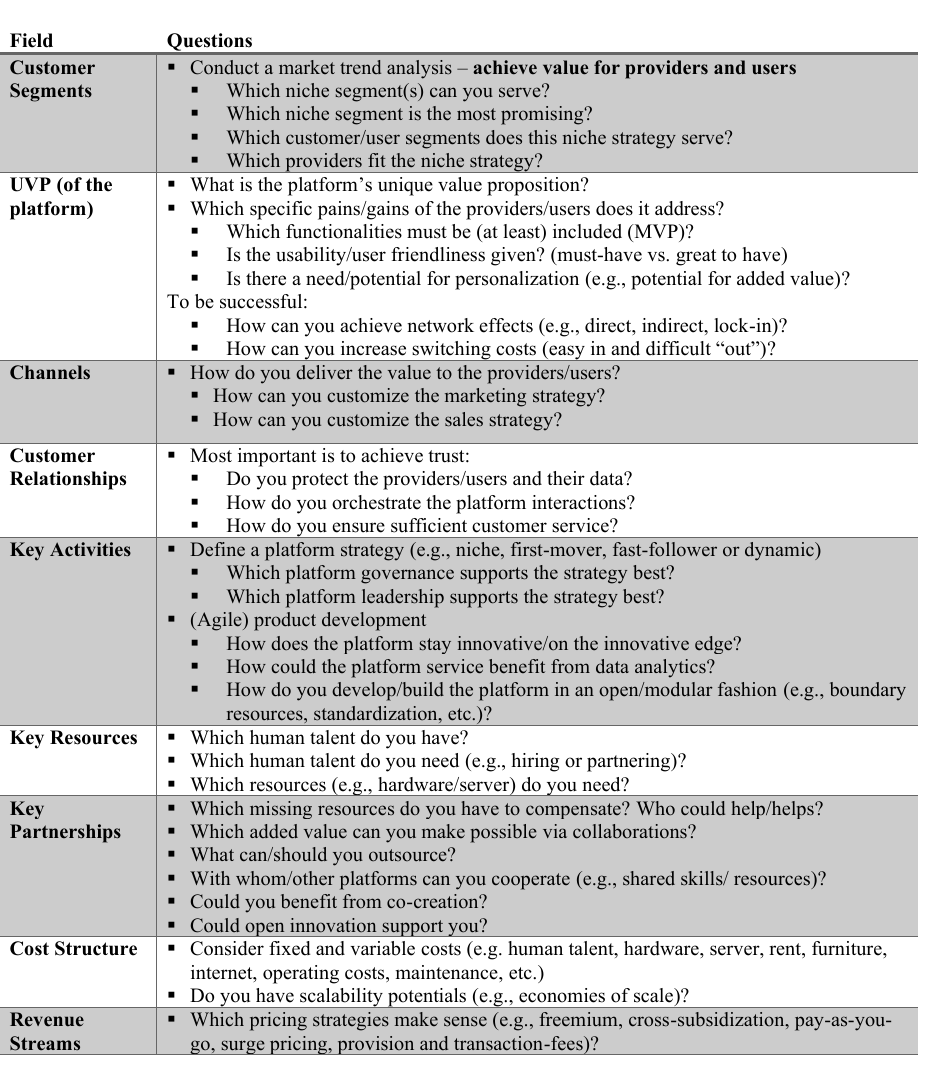
Table 2. Concept table for the platform success –